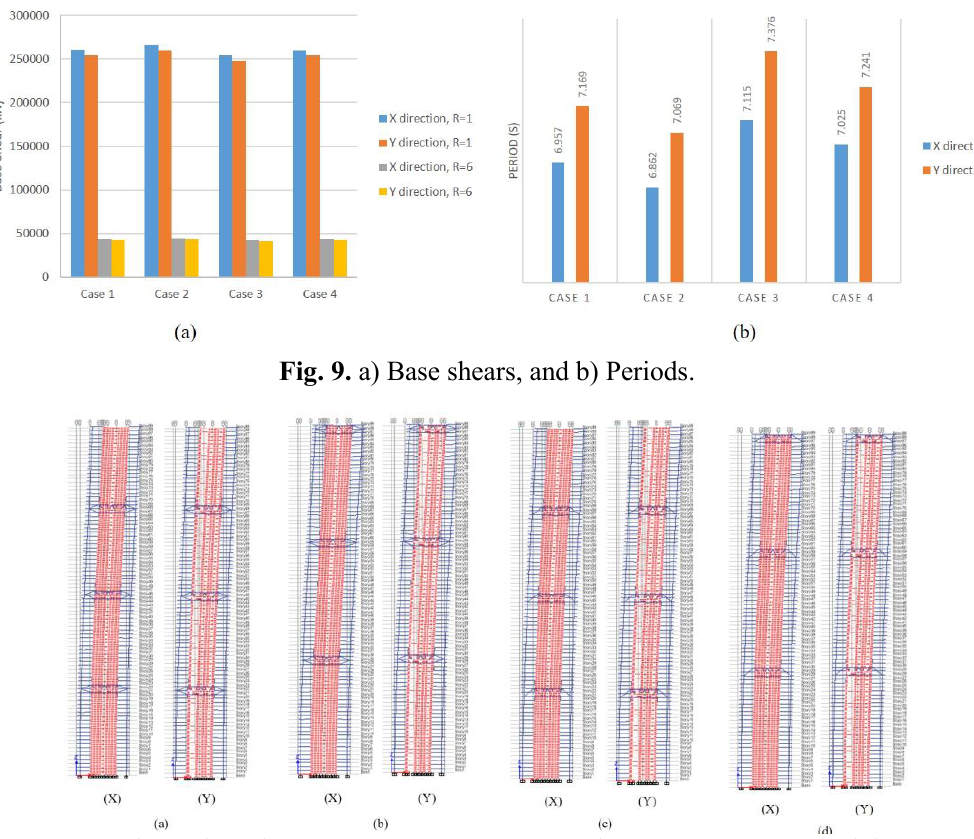
Fig. 10. Deformations for TSC 2017 (R=1) a) case 1, b) case 2, c) case 3, and d) case